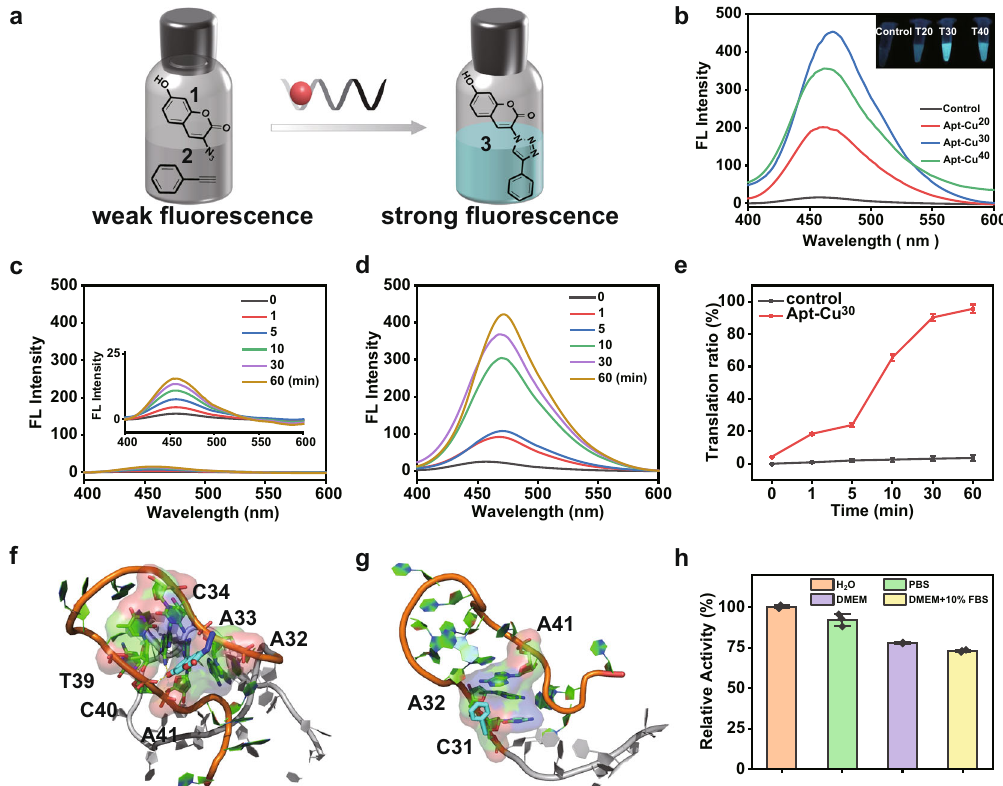
Fig. 2 Characterization of CuAAC reaction in vial. a Scheme of CuAAC reaction catalyzed by Apt-Cu in vial. b Fluorescence spectra of the CuAAC reaction catalyzed by Apt-Cu (with an equivalent amount of copper 5 µ M). (Inset) Fluorescence photogragh of precursors 1 and 2 without and with Apt- Cu. c , d Fluorescence spectra of CuAAC reaction without and with Apt-Cu 30 at different reaction time, respectively. e Translation ratio of precursors 1 and 2 in the absence and presence of Apt-Cu 30 . Data were presented as mean ± SD ( n = 3 independent experiments). f , g The binding mode of precursors 1 and 2 with DNA by molecular docking, respectively. h The relative catalytic capability of the nanocatalyst under different physiological conditions, including in phosphate-buffered saline (PBS), cell culture medium (DMEM) without or with 10% fetal bovine serum (FBS), respectively. Data were presented as mean ± SD ( n = 3 independent experiments). Source data are provided as a Source Data fi